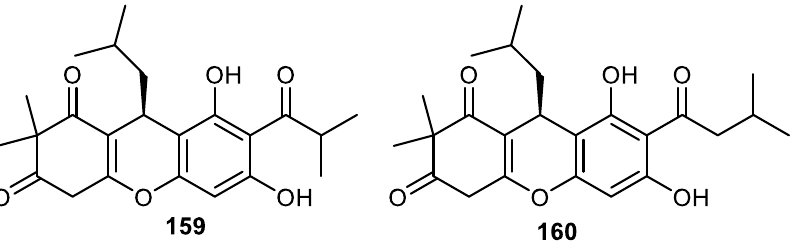
Figure 19. Structures of phloroglucinol 159 and 160